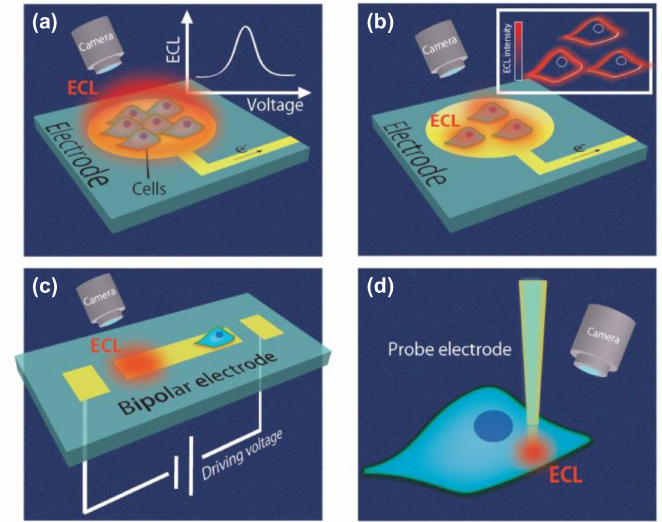
Figure 1. Various electrochemiluminescence (ECL) devices for cell analysis. ( a ) Chip devices not for microscopic imaging. ( b ) ECL microscopes. ( c ) Bipolar electrode (BPE) devices. ( d ) Probe